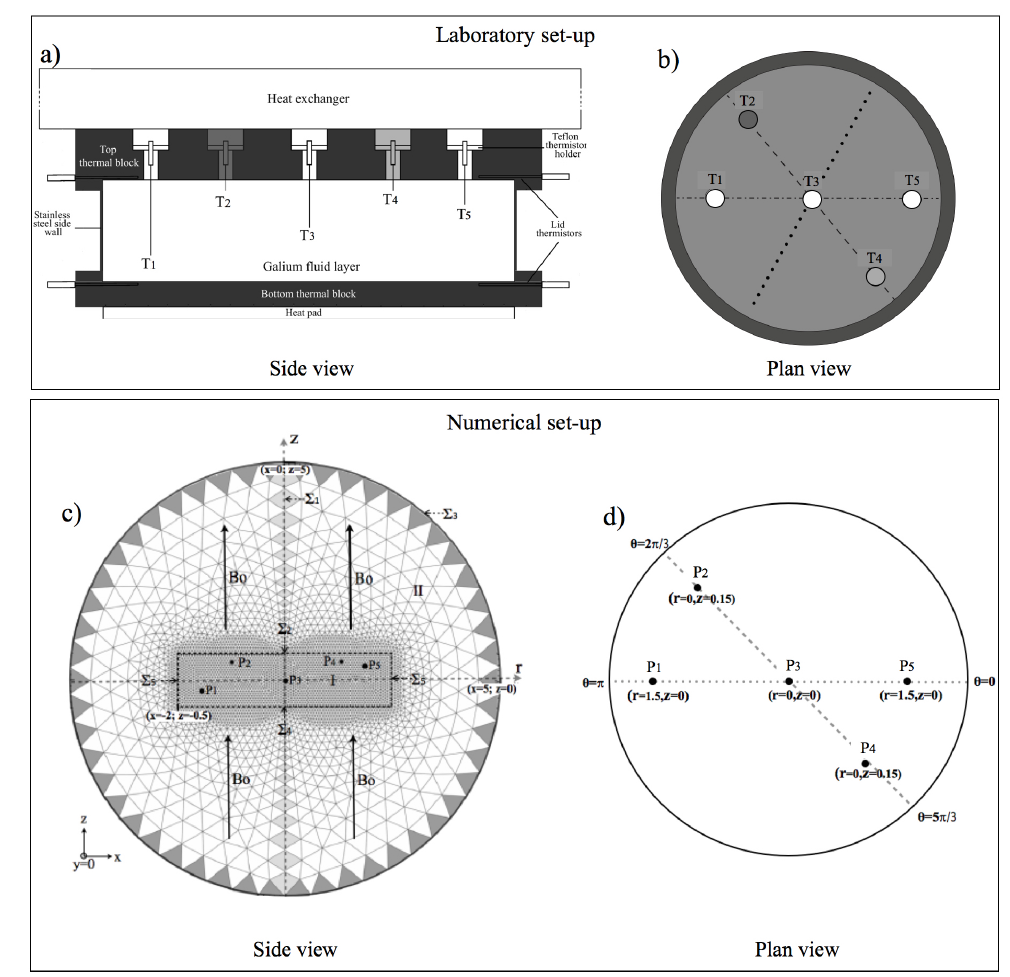
Figure 2. Schematic of the right cylindrical laboratory and numerical convection set-ups used in this study. ( a ) Side view of the experimental convection device. This illustration shows the device with the 5 cm high stainless steel sidewall in place. Lid thermistors measure the temperature difference across the fluid layer, ∆Θ ; internal thermistors, T measure local (dimensional) temperatures, T , inside the fluid layer; ( b ) Plan view (upward facing perspective) of the laboratory experiment’s top thermal block; ( c ) Illustration of a meridian slice of the mesh used in the numerical simulations. In this schematic, the mesh shows only one-tenth of the actual numerical resolution. Points P